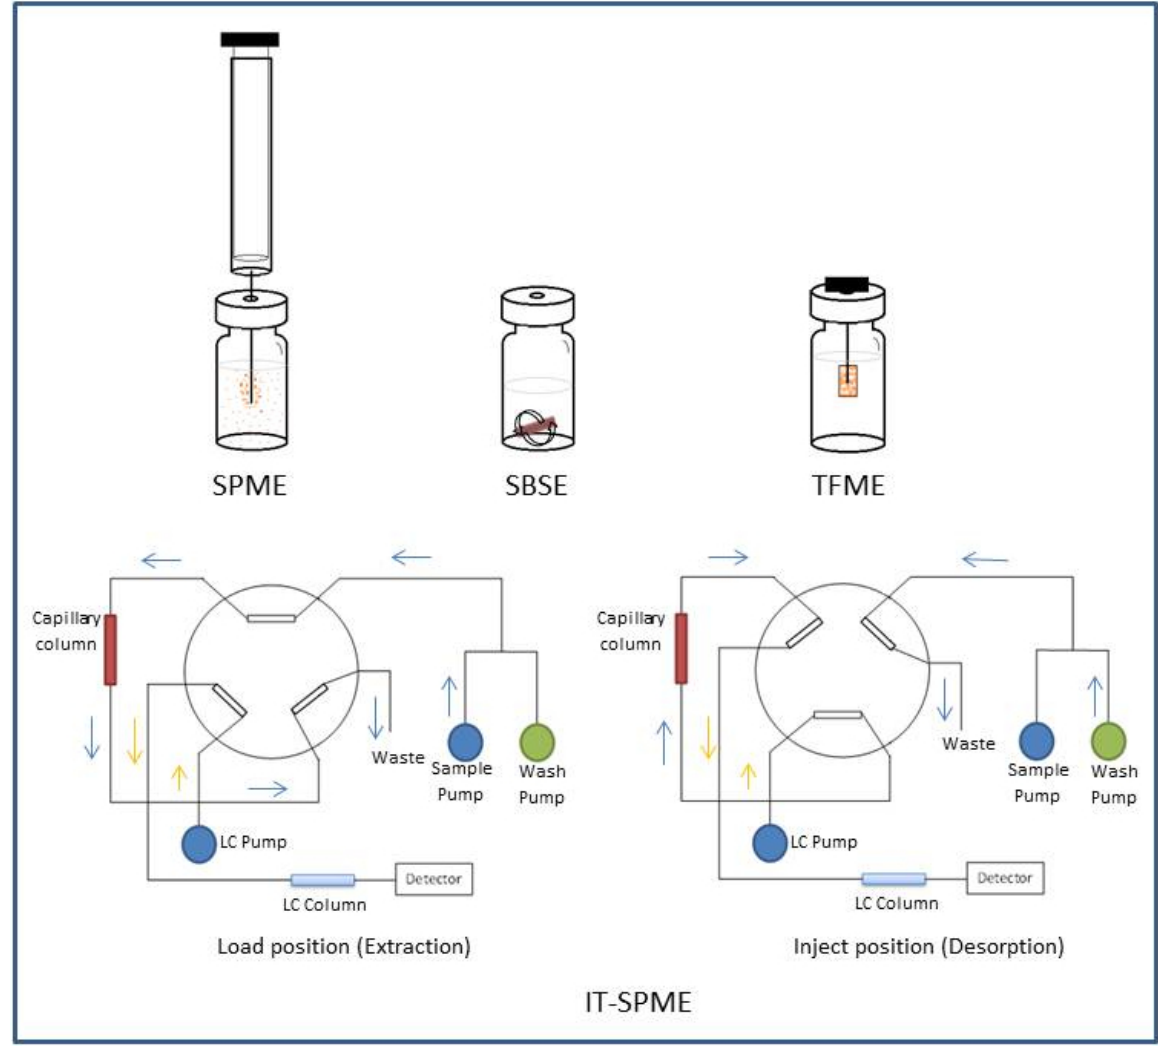
Figure 1. Scheme of some solid phase microextraction